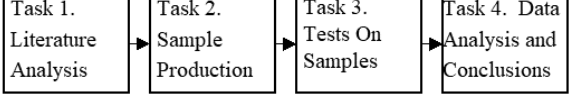
Figure 8: Experiments and analyses organised in tasks